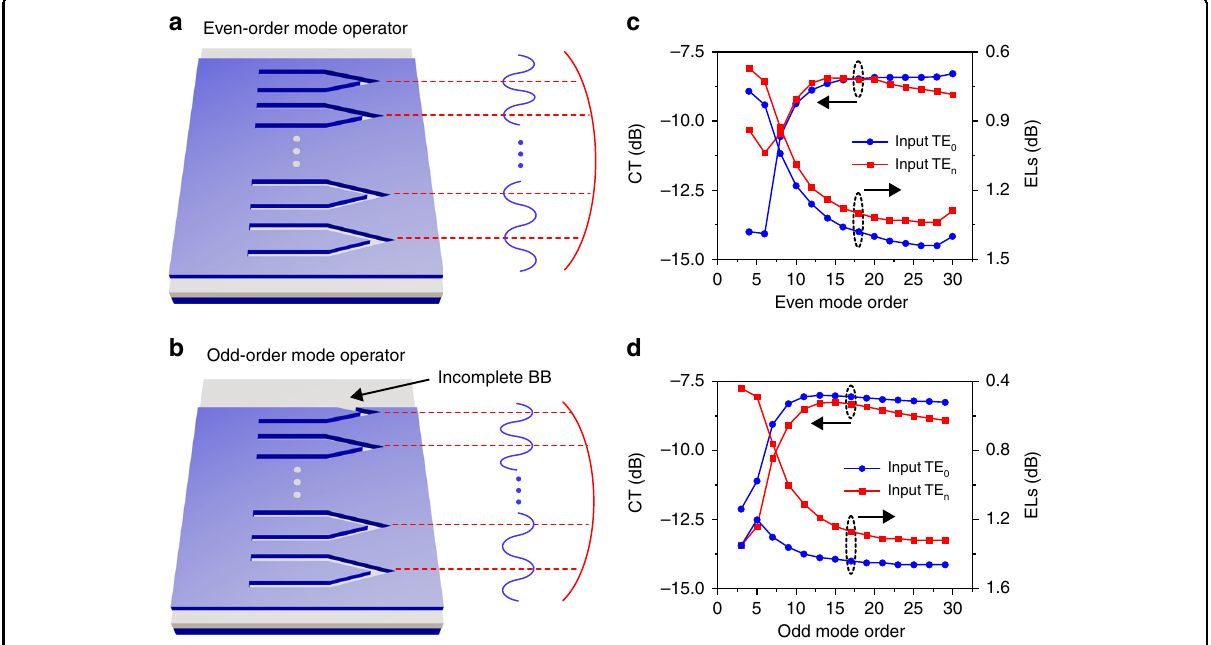
Fig. 3 Design and simulated results for arbitrary high-order mode operator. a , b The 3D view for the even-order and odd-order mode operator, respectively. c , d The corresponding calculated excess losses (ELs) and crosstalk (CT) in the wavelength range from 1500 to 1600